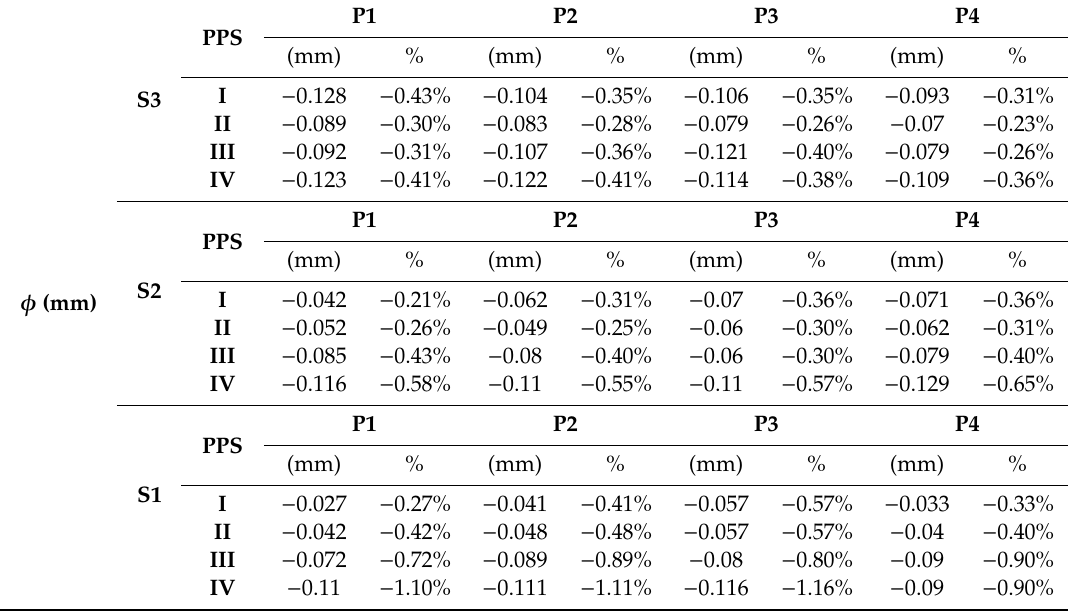
Table A3. External diameter ( φ ) deviations of Shape A artifacts at each post-processing step (as-built I, after stress relief II, after part removal III and after micro shot peening